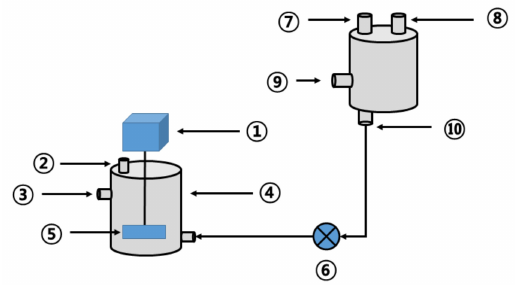
Figure 3. Schematic diagram of the thermal hydrolysis device and high-temperature anaerobic digester